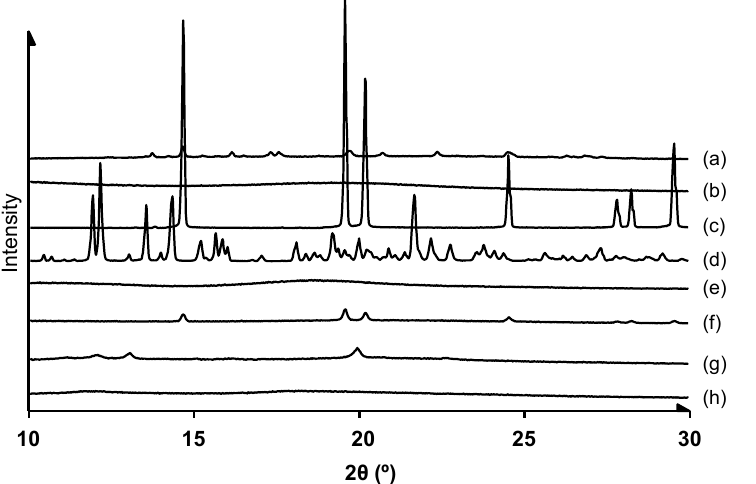
Figure 1. X-ray diffraction patterns of various samples (a) Silymarin (SLM) original, (b) hypromellose (HPMC) original, (c) erythritol (Ery) original, (d) α -cyclodextrin ( α -CyD) original, (e) hydroxypropyl (HP)- β -CyD original, (f) SLM/HPMC/Ery NPs (1/1/1), (g) SLM/HPMC/ α -CyD NPs (1/1/1), (h) SLM/HPMC/HP- β -CyD NPs (1/1/1). The weight ratio of SLM/HPMC/stabilizers was 1/1/1.